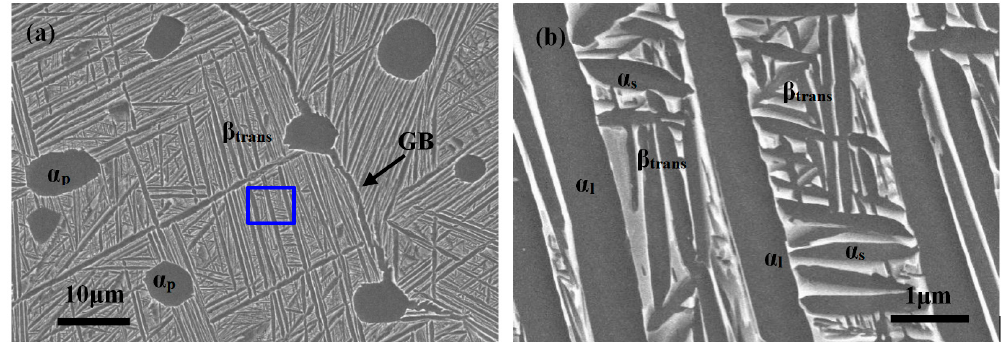
Figure 1. The SEM features of the trimodal microstructure (TM) before deformation: ( a ) three different α morphologies, namely, the primary equiaxed α phase ( α p ), the lamellar α phase ( α l ) and the secondary α phase( α s ); ( b ) the morphology of α l and α s in the β trans matrix.